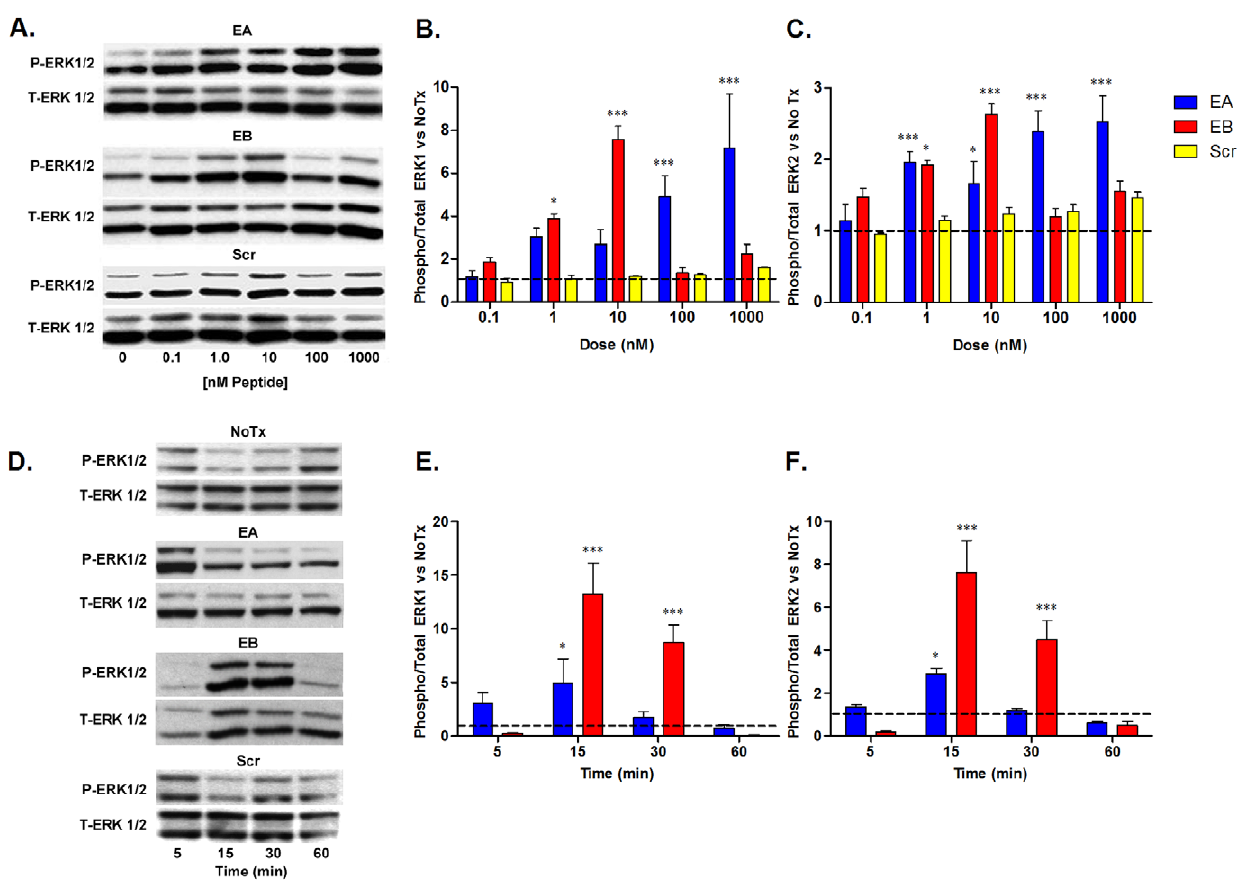
Figure 2. EA and EB increase MAPK signaling in C2C12 cells. A . Cells were starved in media without serum, and treated with synthetic E- peptides at concentrations indicated for 20 minutes. Protein lysates were separated via SDS-PAGE and immunoblotted for Phosphorylated ERK 1 and 2 (P-ERK1/2), stripped, and blotted for Total ERK 1 and 2 (T-ERK1/2). B–C . Quantification of A. D . Cells were treated as above at optimal doses (EA and Scr 1 m M, EB 10 nM) for times indicated. E–F Quantification of C. NoTx at 30 minutes was included in each experiment for normalization between blots. For B–C and E–F, bars represent means 6 s.e.m. of N=3 replicates. *, p , 0.05; ***, p , 0.001, for comparisons to NoTx via 2-way ANOVA followed by a Bonferroni